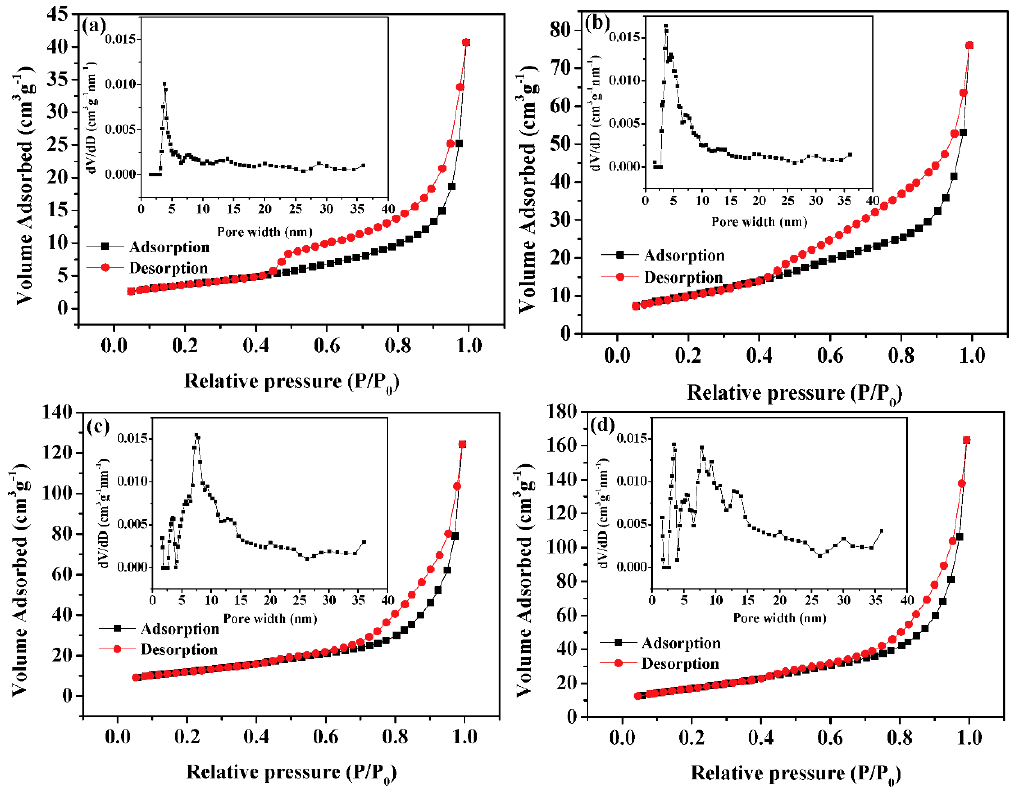
Figure 4. N 2 absorption-desorption isotherms of ( a ) MoO 3 -doped MnCo 2 O 4 (0), ( b ) MoO 3 -doped MnCo 2 O 4 (0.04), ( c ) MoO 3 -doped MnCo 2 O 4 (0.10), and ( d ) MoO 3 -doped MnCo 2 O 4 (0.12) (inset: Pore size distribution).